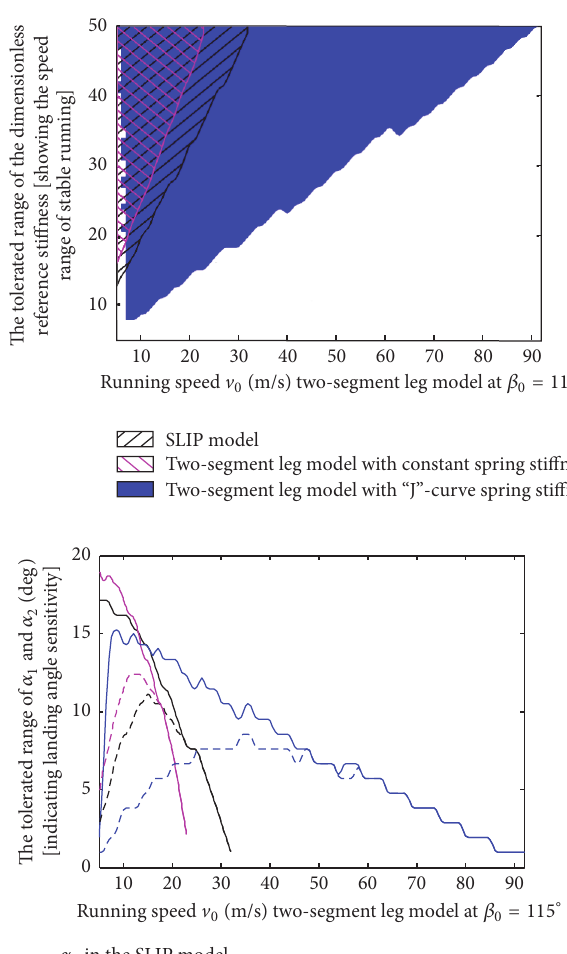
𝛼 1 in the SLIP model 𝛼 1 in the two-segment leg model with constant spring stiffness 𝛼 1 in the two-segment leg model with “J”-curve spring stiffness 𝛼 2 in the two-segment leg model with constant spring stiffness 𝛼 2 in the two-segment leg model with “J”-curve spring stiffness